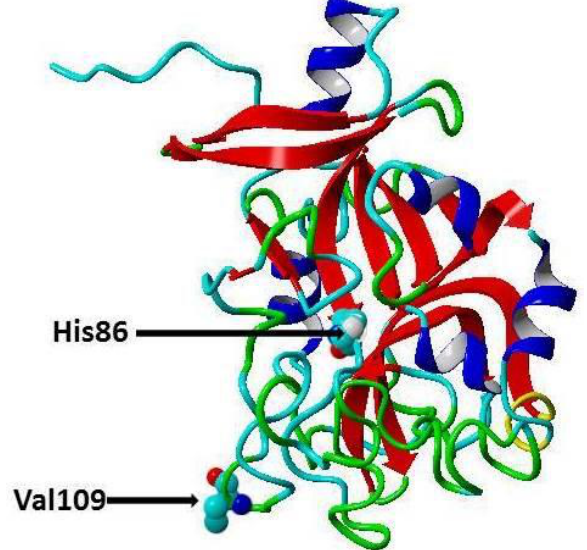
Figure 1. Secondary cartoon structure of human omentin (PDB ID 4WMQ [19]. The amino acid residues, Valine 109 (rs2274907) and the Histidine 86 (rs2274908), are shown in atom presentation.